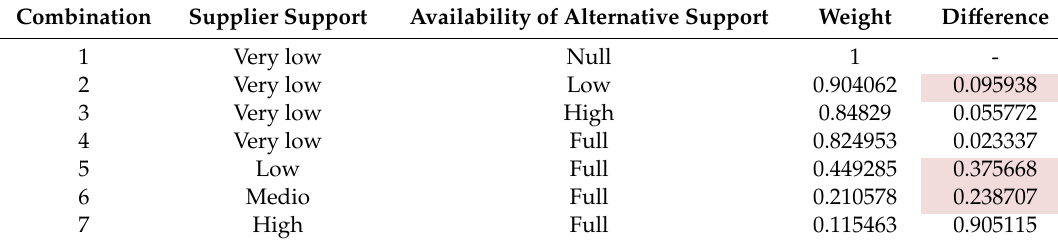
Table 19. Top–down technique for the criterion Availability of support.